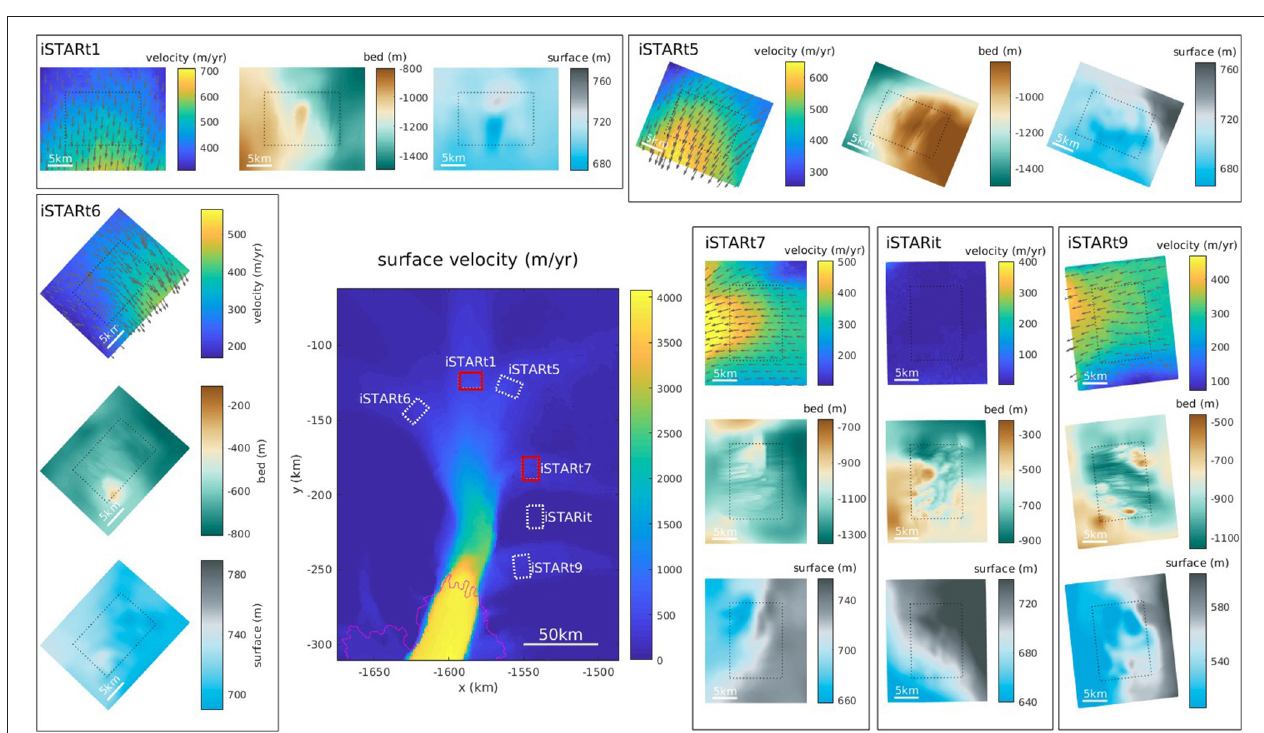
FIGURE 2 | Location of high-resolution data patches on Pine Island Glacier that are used in this study. Results for the two outlined in red are presented in the main part of this paper; results for the other four are in the Appendix (Supplementary Material). For each of the locations we show the velocity (Fahnestock et al., 2016), together with the bed and surface elevation fields (plotted relative to sea level). The thin black dashed box outlines the 10 × 15km 2 area over which the DELORES elevation data were collected; the data is merged with BEDMAP2 elevations outside of this box ( Fretwell et al., 2013).